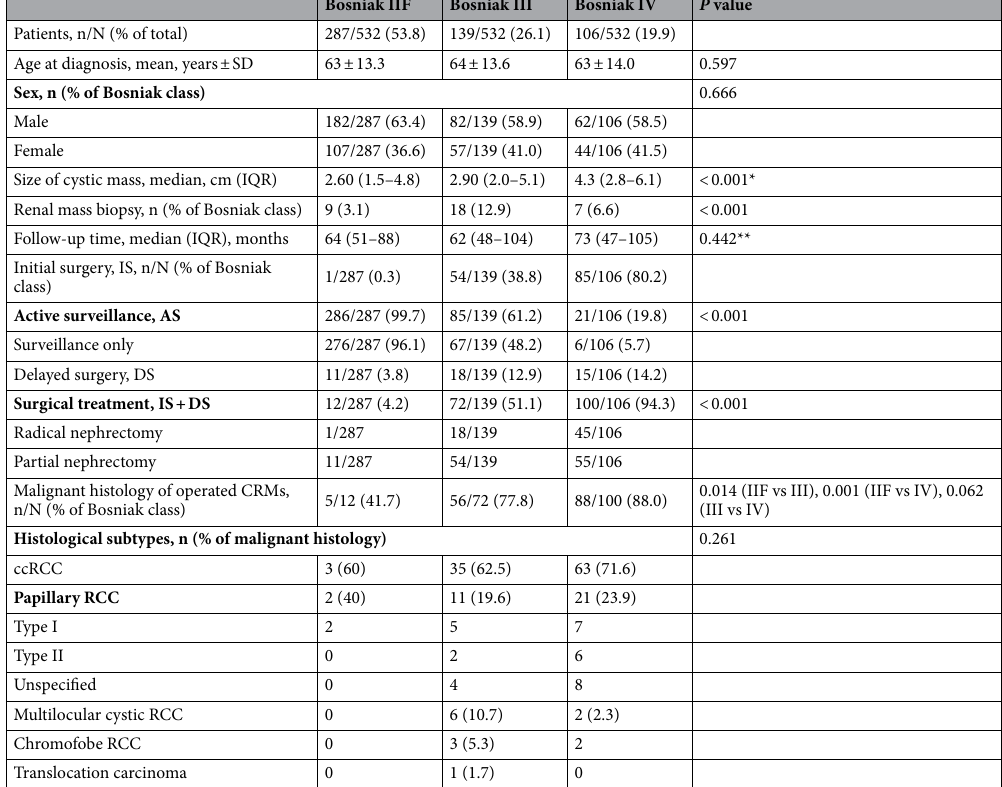
Table 1. Clinical characteristics of patients and histology of CRMs by Bosniak stratification. CRM complex cystic renal mass, ccRCC clear cell renal cell carcinoma, RCC renal cell carcinoma. P values were calculated using the Kruskall–Wallis and Fisher exact test. *IIF versus III p = 0.447, IIF versus IV p < 0.001, III versus IV p < 0.001. **IIF versus III p = 0.684, IIF versus IV p = 0.107, III versus IV p =